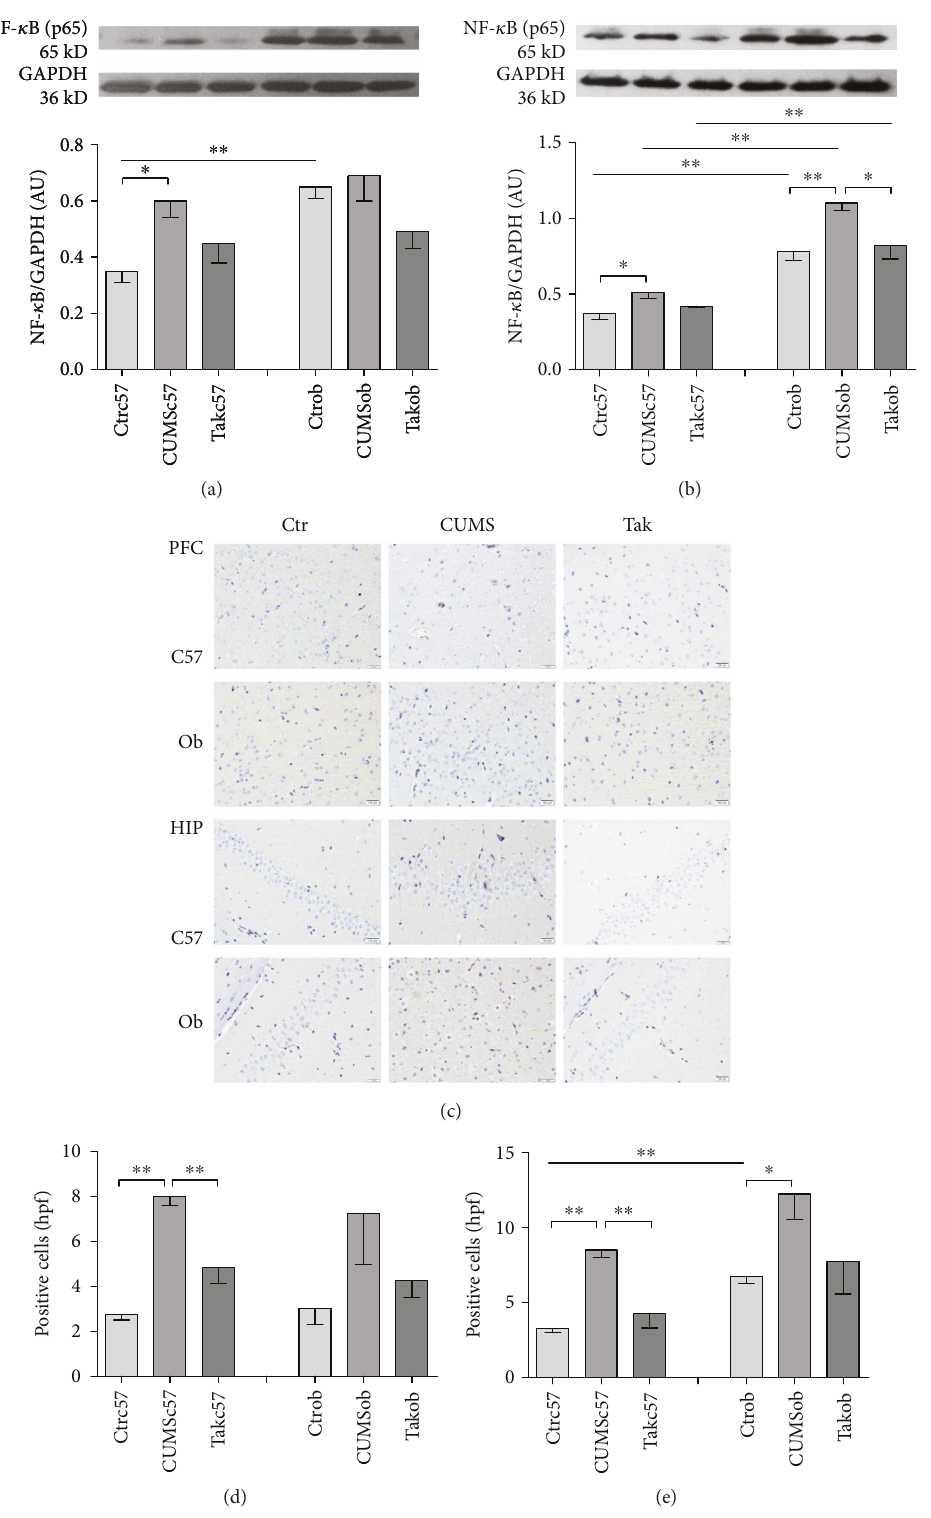
Figure 5: NF- κ B p65 expression in the frontal cortex and hippocampus. (a) NF- κ B p65 expression in the frontal cortex measured in Western blot. (b) NF- κ B p65 expression in the hippocampus measured in Western blot. (c) NF- κ B p65 expression in the frontal cortex and hippocampus in immunohistochemistry ( × 400). Above: frontal cortex; below: hippocampus. (d) Positive expression neuron counting in the frontal cortex in a high-power fi eld (hpf). (e) Positive expression neuron counting in the hippocampus in a high-power fi eld (hpf). Data are expressed as means ± SEM ( n = 6 in each group and n = 4 in each group). ∗ p < 0 05 and ∗∗ p < 0 01